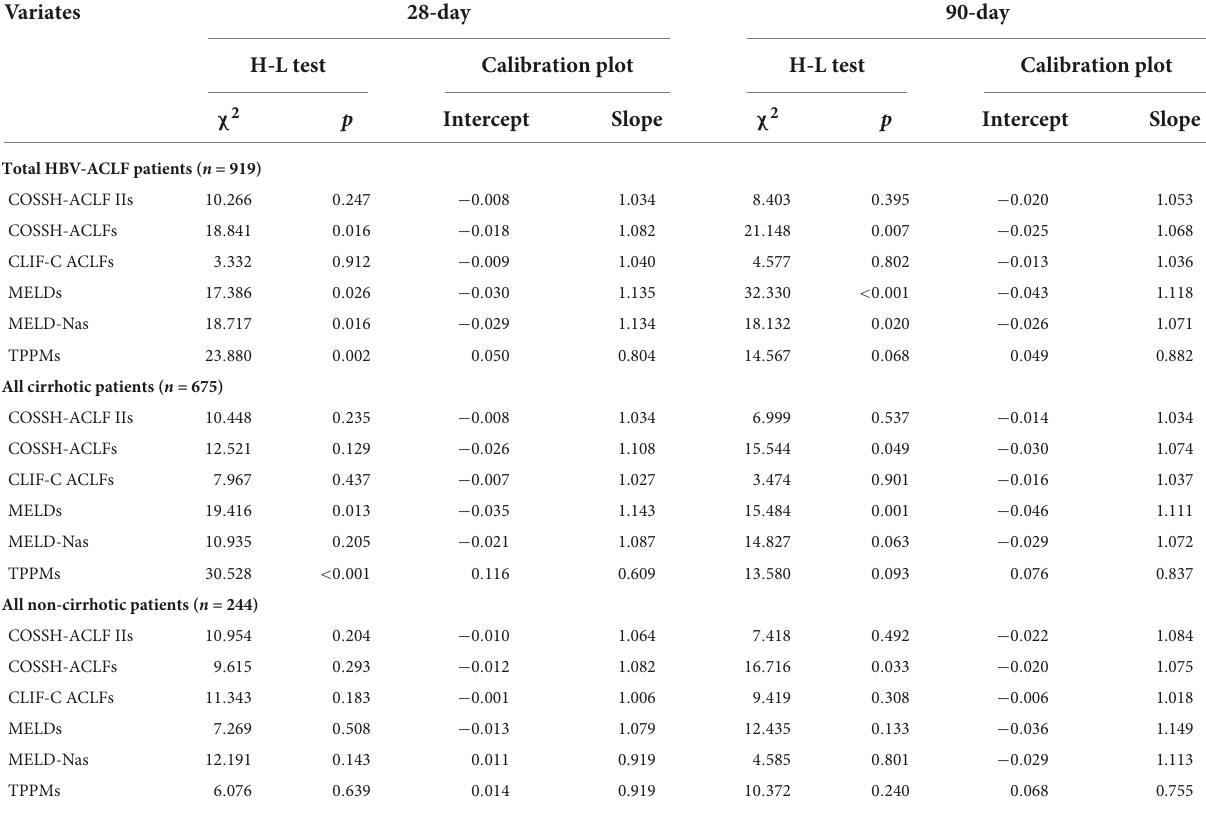
TABLE 3 Calibration analysis for each score at 28-day and 90-day.